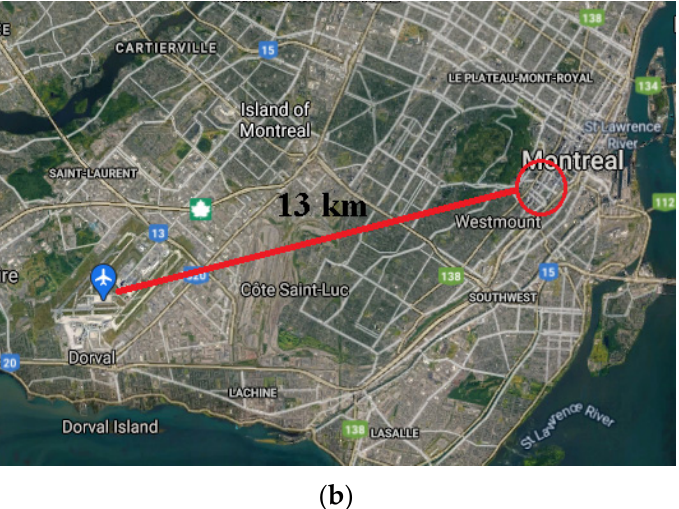
Figure 3. Urban image of the case study. ( a ) Case study: downtown Montreal, Canada with the local weather station indicated. ( b ) Airport position relative to downtown Montreal with the selected downtown region circled.